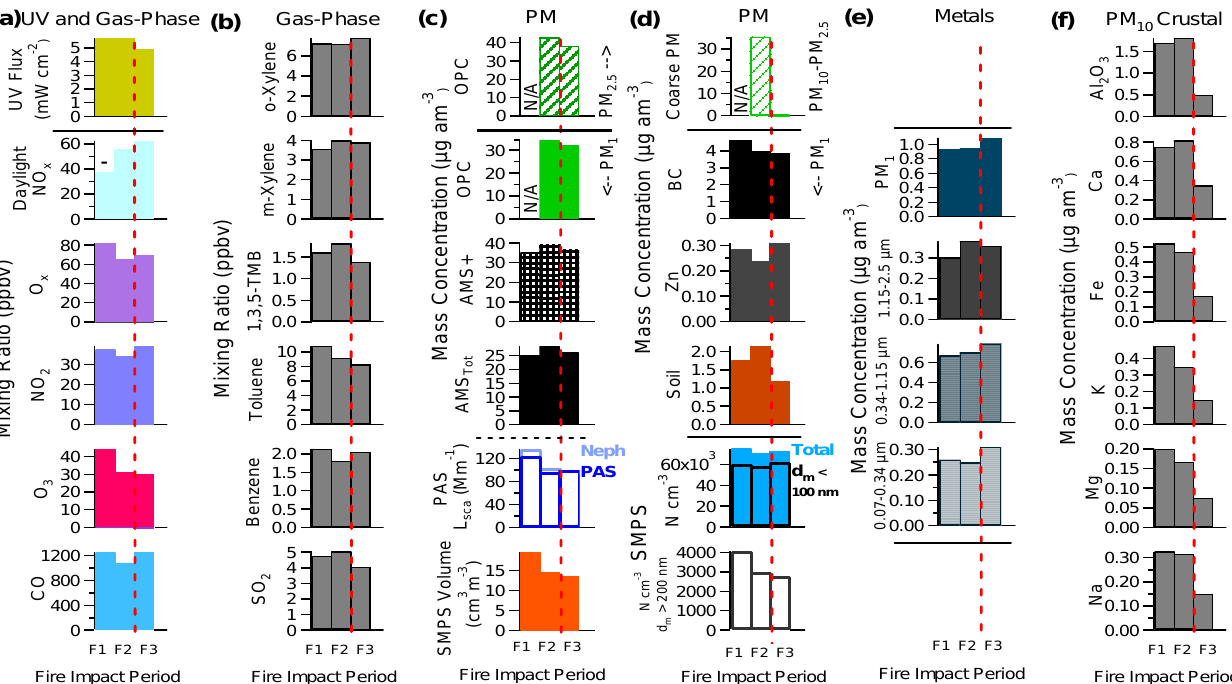
Figure 9. Fire period analysis graphs, comparing the average values of different parameters for the high fire (F1, F2) and low fire (F3) periods, including (a) UV flux and gas-phase species; (b) aromatic hydrocarbons and SO 2 ; (c) six different measures of fine PM concentration; (d)-(f) particle-phase species. (Legend: - = less than 30% time series, N/A = no data)